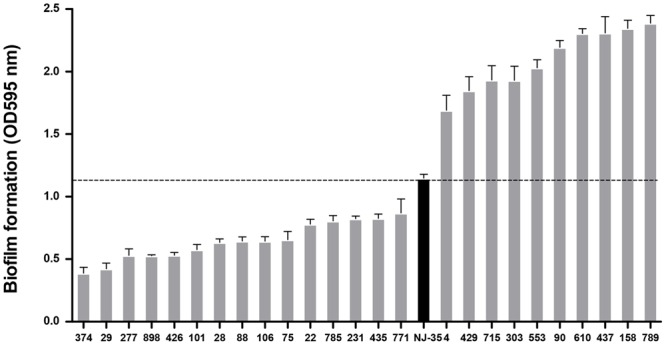
Biofilm formation of the mutants compared to the wild-type strain NJ-35. A total of 25 mutants in which transposon insertion sites were identified were ranked in this figure based on their biofilm formation abilities. The black column represents the wild-type strain NJ-35.